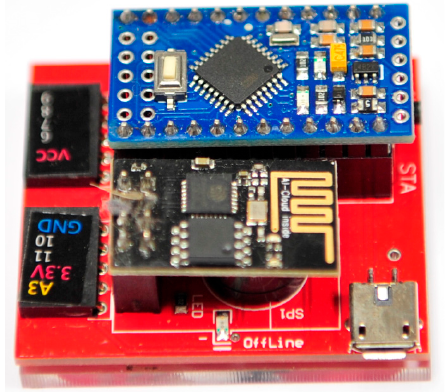
Figure 2. Webduino control board.